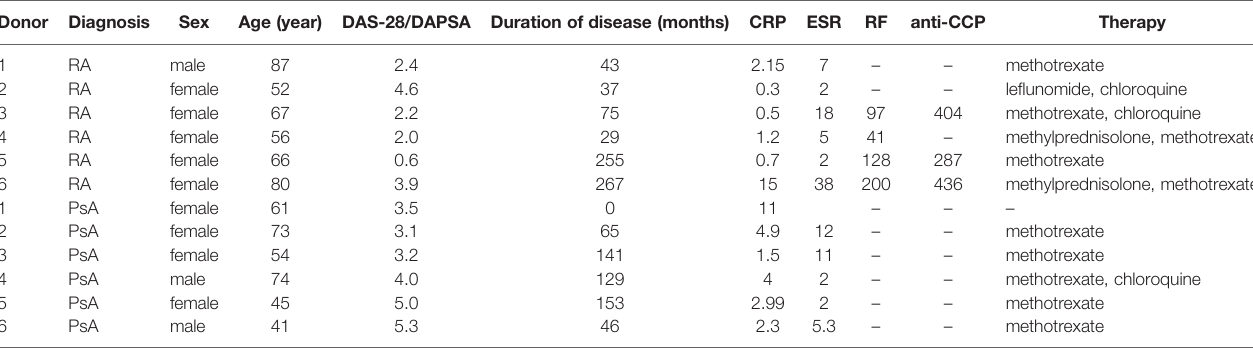
TABLE 1 | Basic patient